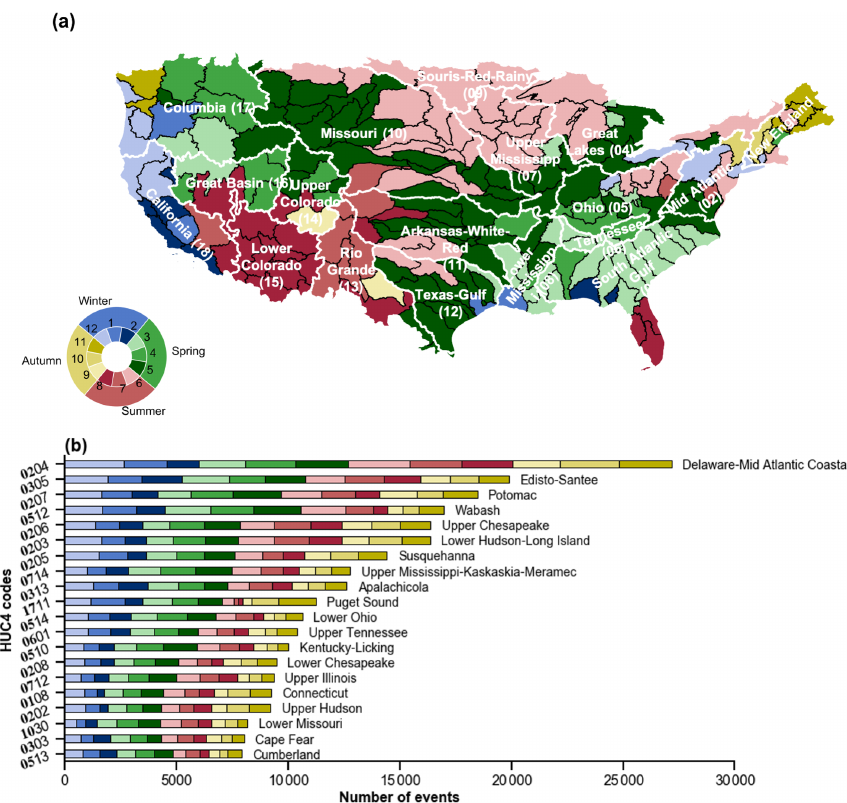
Figure 3. (a) Map of months with largest flood occurrence in major US watersheds (Hydrologic Unit Code 4). (b) Flood occurrences of the top 20 HUC4 basins (HUC2 codes in bold), grouped by